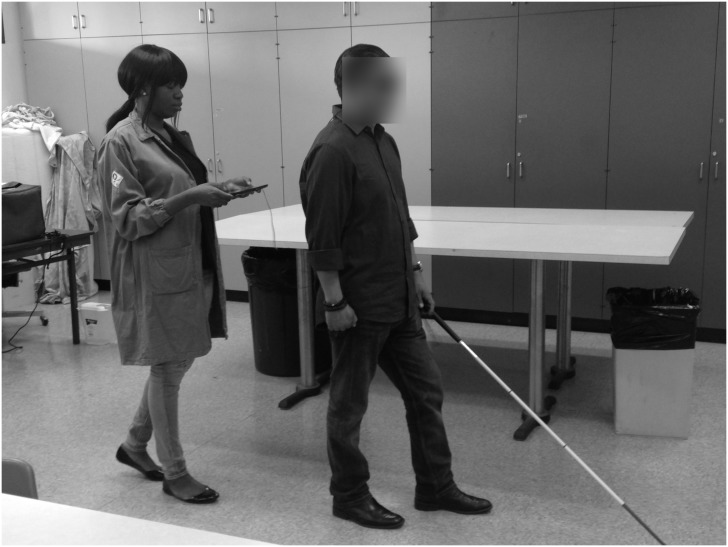
Indoor testing with the Audible Mobility Feedback System.Researcher guiding subject using the Audible Mobility Feedback System (aMFS) during an indoor testing session.